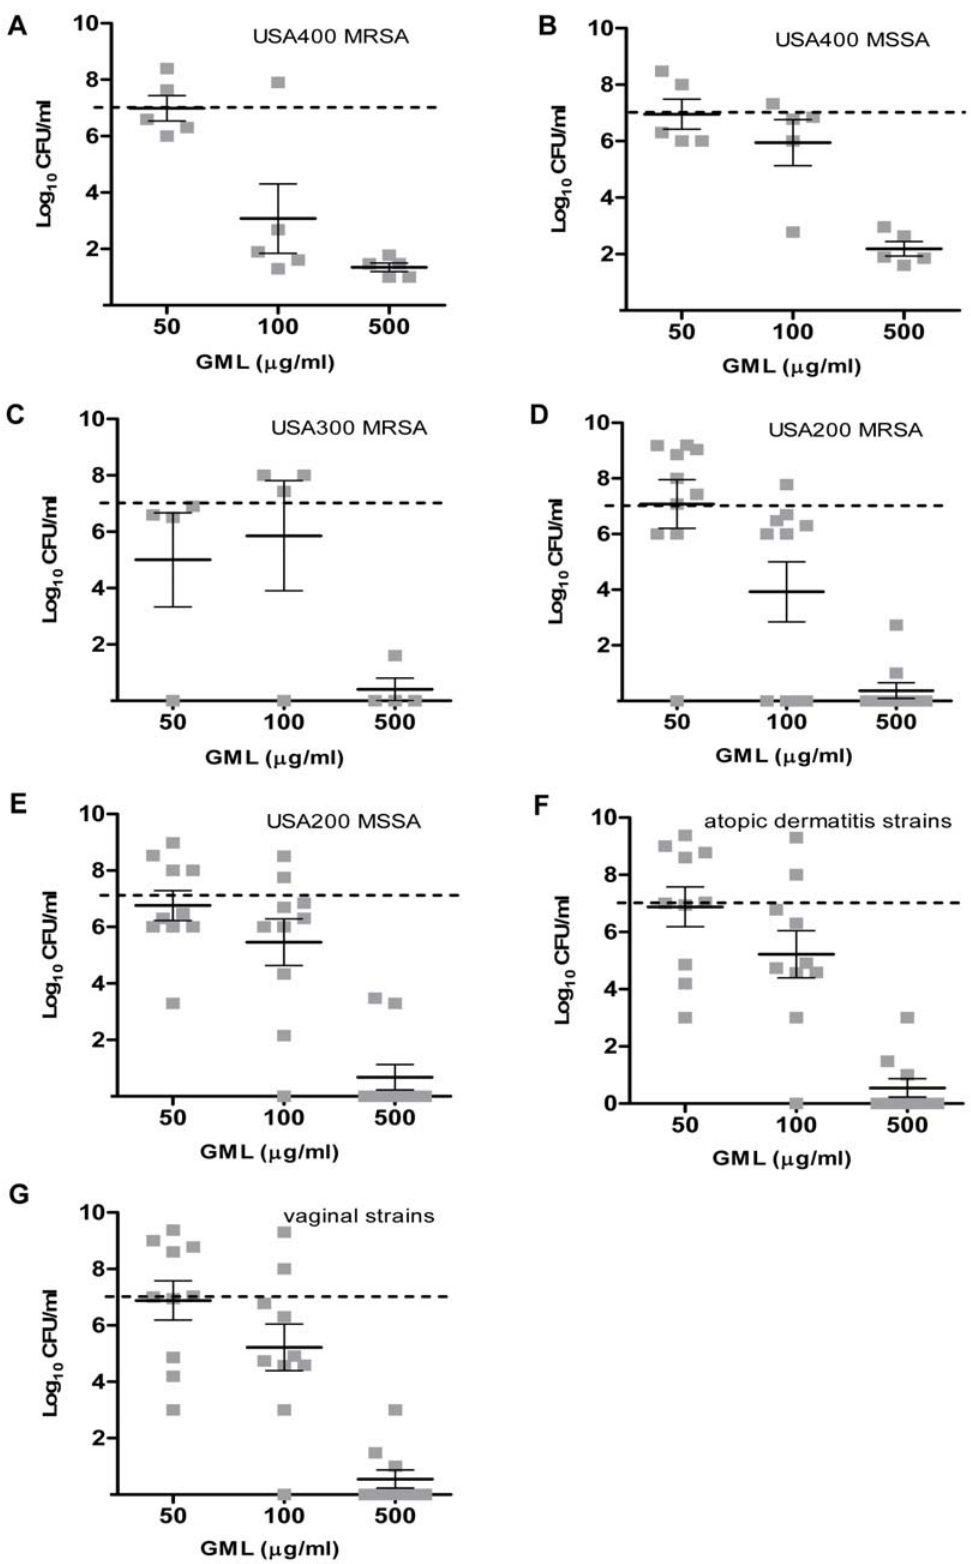
Figure 2. Glycerol monolaurate (GML) inhibition of Staphylococcusaureus . GML concentrations 50, 100, and 500 m g/ml were tested versus S. aureus isolates from different PFGE types, USA400 MRSA (A), USA400 MSSA (B), USA300 MRSA (C), USA200 MRSA (D), USA200 MSSA (E), atopic dermatitis strains (F), vaginal strains from healthy women (G), for 18 h at 37 u C with shaking. The dashed line indicates the starting inocula. Each square ( & ) indicates one isolate. The bars represent the mean 6 SEM of bacterial density in the group.